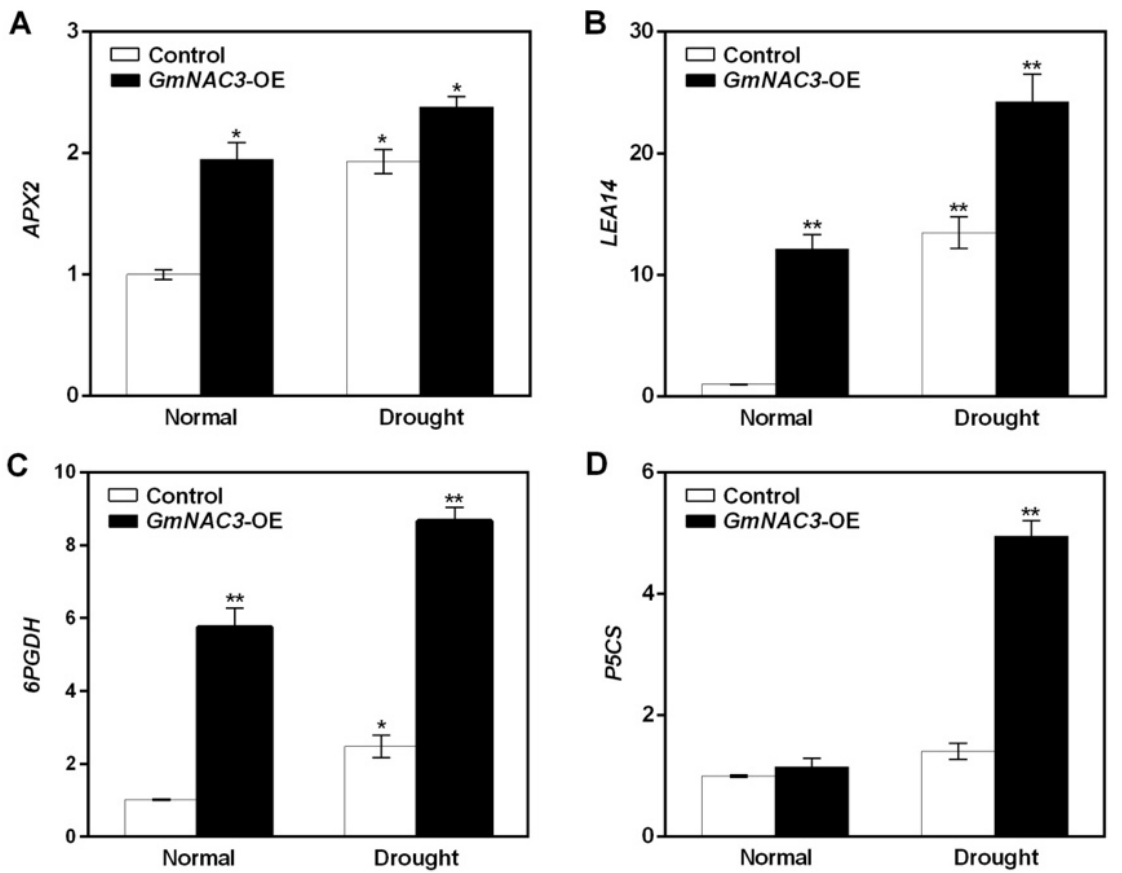
Figure 10. Relative expression of four drought response-related genes, i.e., APX2 ( A ), LEA14 ( B ), 6PGDH ( C ), and P5CS ( D ), in transgenic soybean plants with the overexpression of GmNAC3 gene under drought stress relative to the control under normal growth condition (non-drought) based on quantitative real-time PCR analysis. Symbols “*” and “**” indicate significant differences at p values of 0.05 and 0.01, respectively.